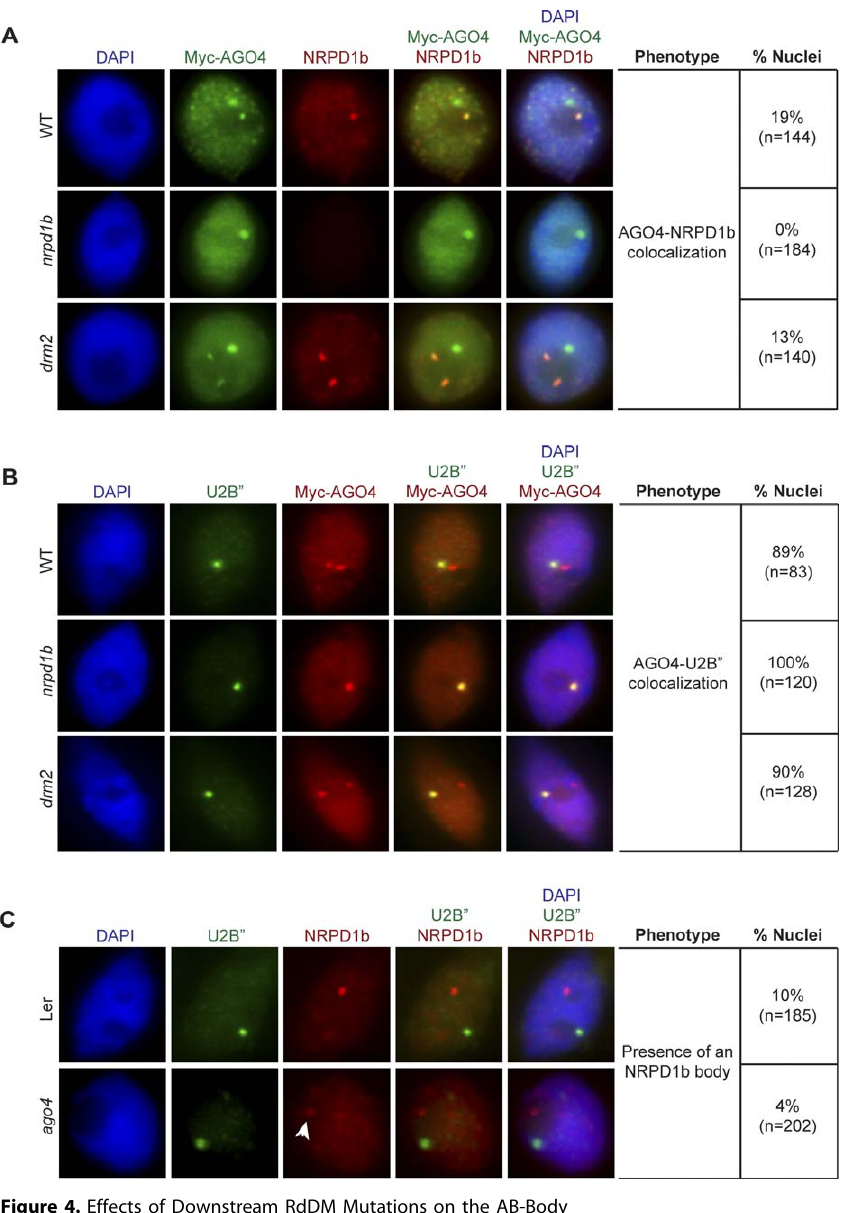
Figure 4. Effects of Downstream RdDM Mutations on the AB-Body (A,B) Myc-AGO4 nuclear localization in wild type, nrpd1b , or drm2 mutant nuclei is shown relative to the immunostaining of (A) NRPD1b or (B) U2B 99 . (C) Immunolocalization of NRPD1b and U2B 99 in wild type (Ler) or an ago4 mutant. The white arrow indicates a less intense NRPD1b body that